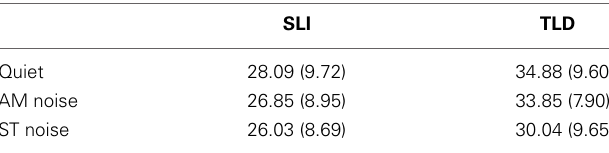
Table 7 | Mean percent correct responses for VO in quiet, AM noise and ST noise.